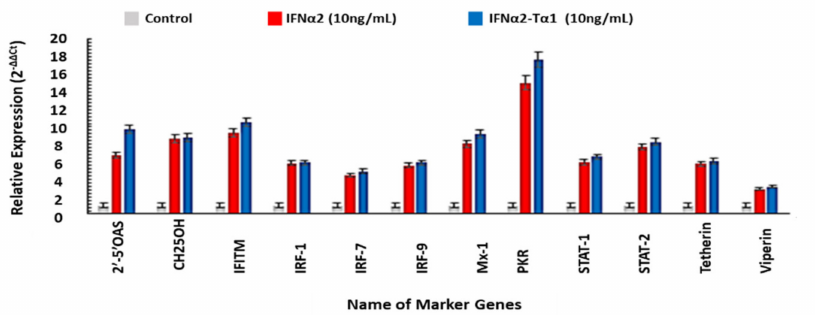
Figure 7. Relative expression of 2 (cid:48) ,5 (cid:48) -OAS, CH25OH, IFITM, IRF-1, IRF-7, IRF-9, MX-1, PKR, STAT-1, STAT-2, Tetherin, and Viperin genes measured by quantitative real-time PCR in IFN α 2–T α 1-treated cells compared with IFN α 2-treated cells. These data are presented as means of triplicate PCR experiments. Data are represented as Mean ± SD (n = 3, two-way ANOVA, p < 0.05 considered significant with 95% confidence).